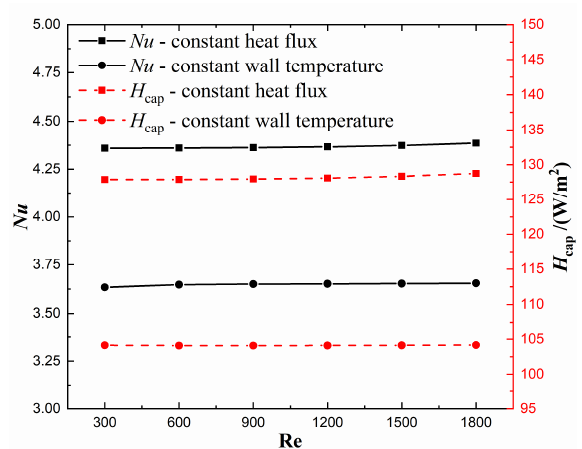
Figure 7. The variation of Nusselt number and heat convection intensity of the fully developed tube flow.